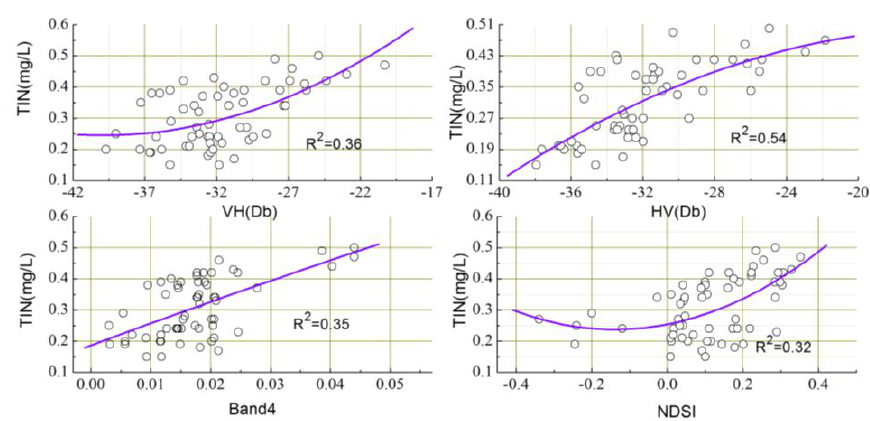
Figure 2. Relationship between different optical parameters, polarization parameters and